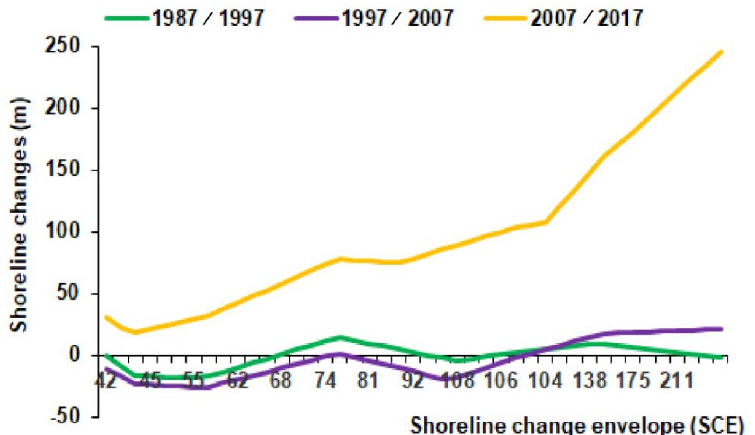
Figure 7. Profile of shoreline change vs. shoreline change envelope in the south of the harbor.